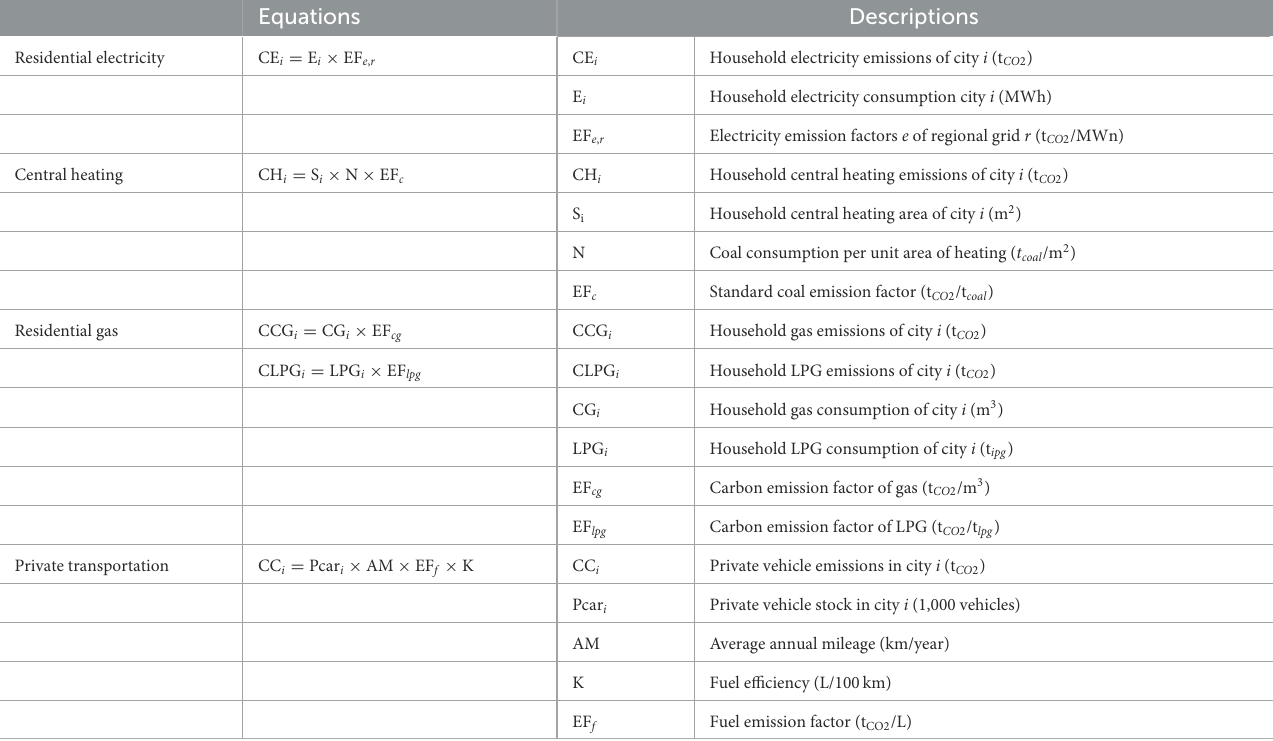
TABLE 1 Accounting carbon emissions inventory.